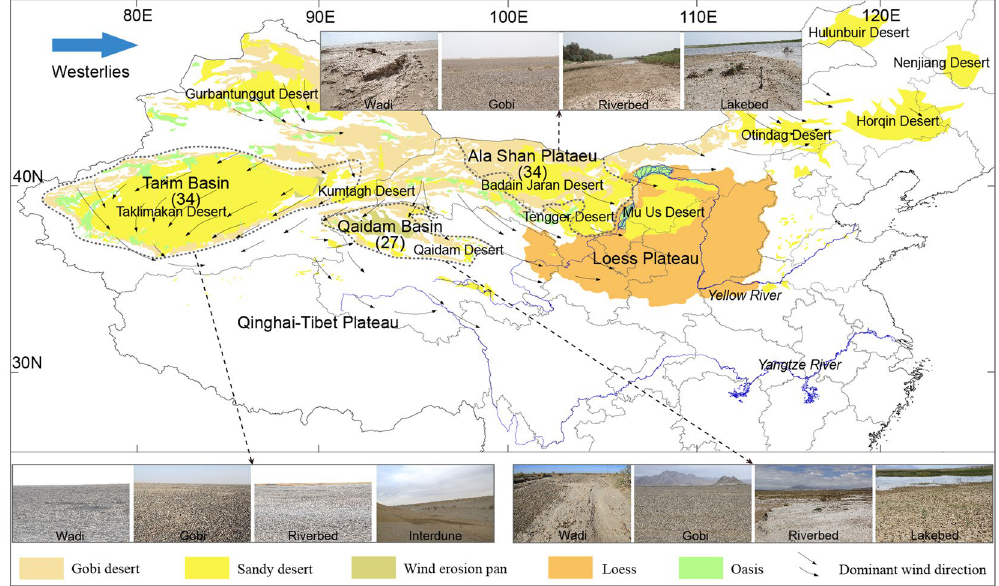
Figure 1. Locations of the Qaidam Basin, Ala Shan Plateau, Tarim Basin, and the landscapes with high modern dust aerosol emissions. Numbers within the brackets are the number of samples. The figure was finished using Arcgis software (version 10.1, ESRI Inc., Redlands, California, USA), which can be downloaded from the internal network of Institute of Geographic Sciences and Natural Resources Research, Chinese Academy of Sciences.